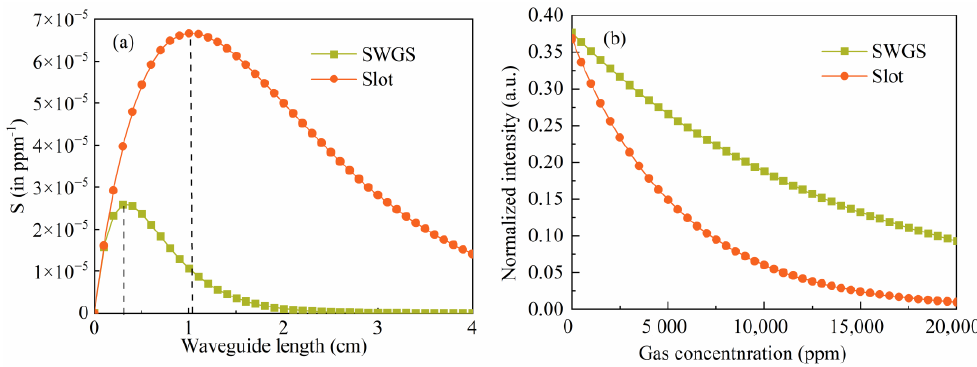
Figure 7. ( a ) Variation of sensitivity with waveguide length; ( b ) variation of normalized intensity with dioxide carbon gas concentration for the SWGS waveguide and slot waveguide.